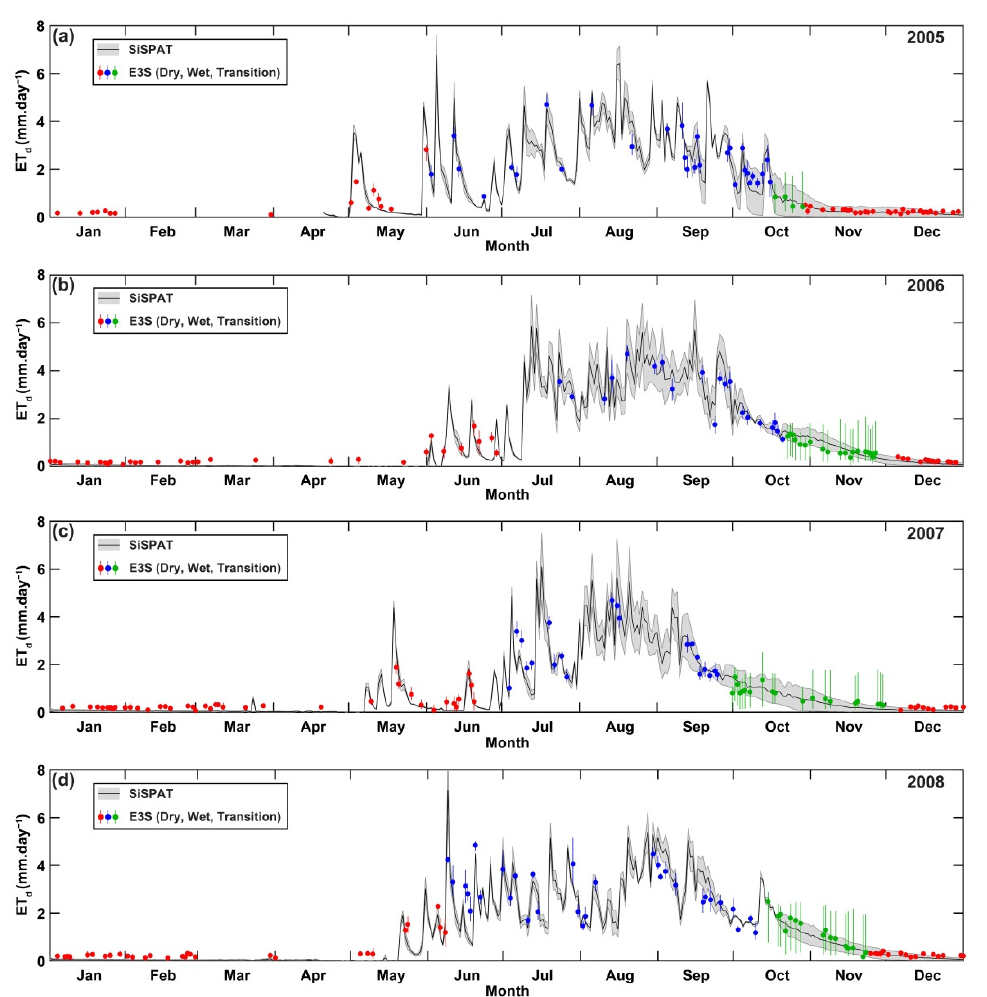
Figure 9. E3S blended daily ET d for ( a ) 2005, ( b ) 2006, ( c ) 2007, and ( d ) 2008 from MODIS combined TERRA-AQUA data versus SiSPAT-simulated ET d . Error bars represent the conditional ensemble range. The shaded grey area represents the variation between the two simulated sites (millet and fallow plots).